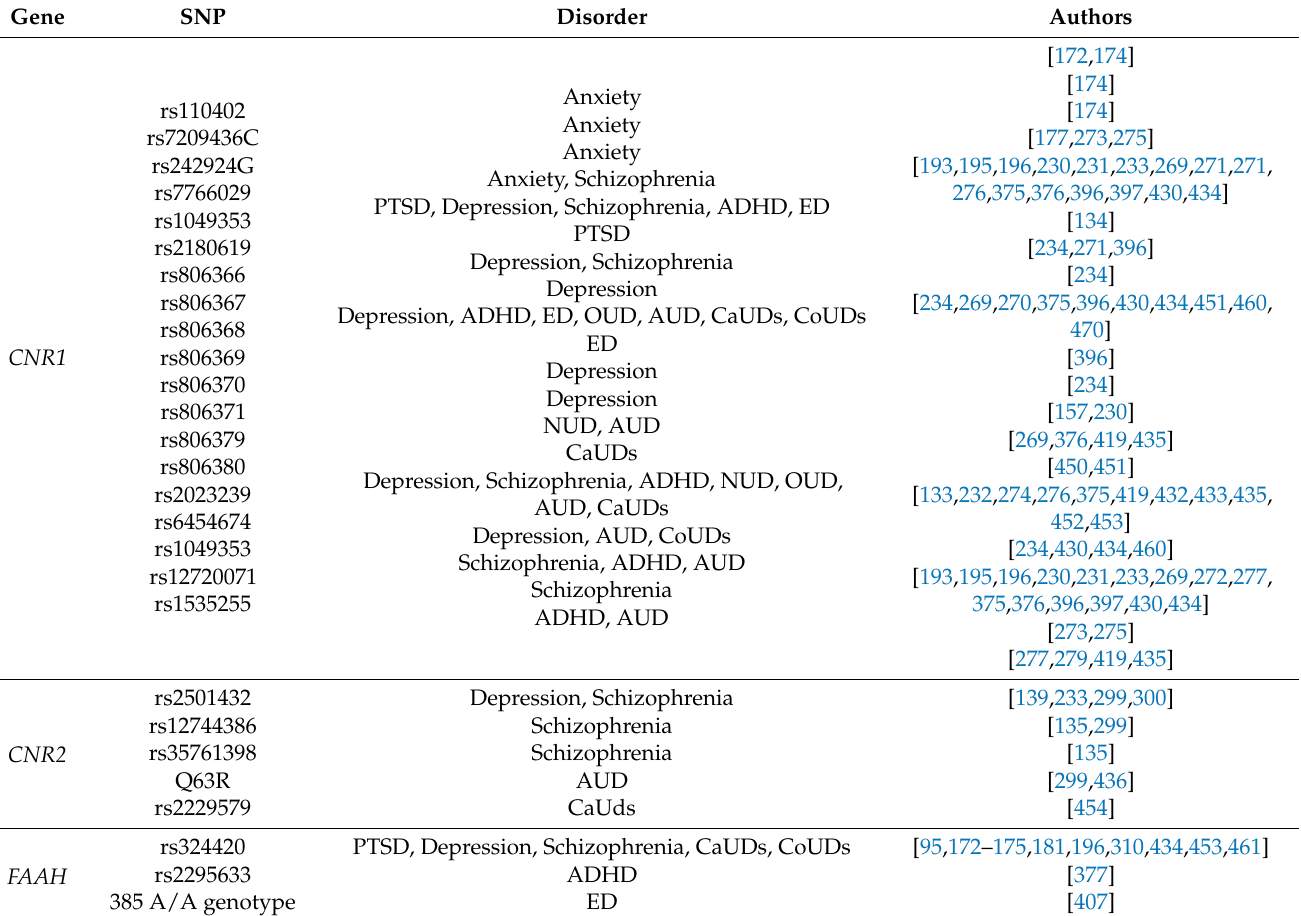
Table 6. Summary of the main ECS candidate genes polymorphisms associated with each